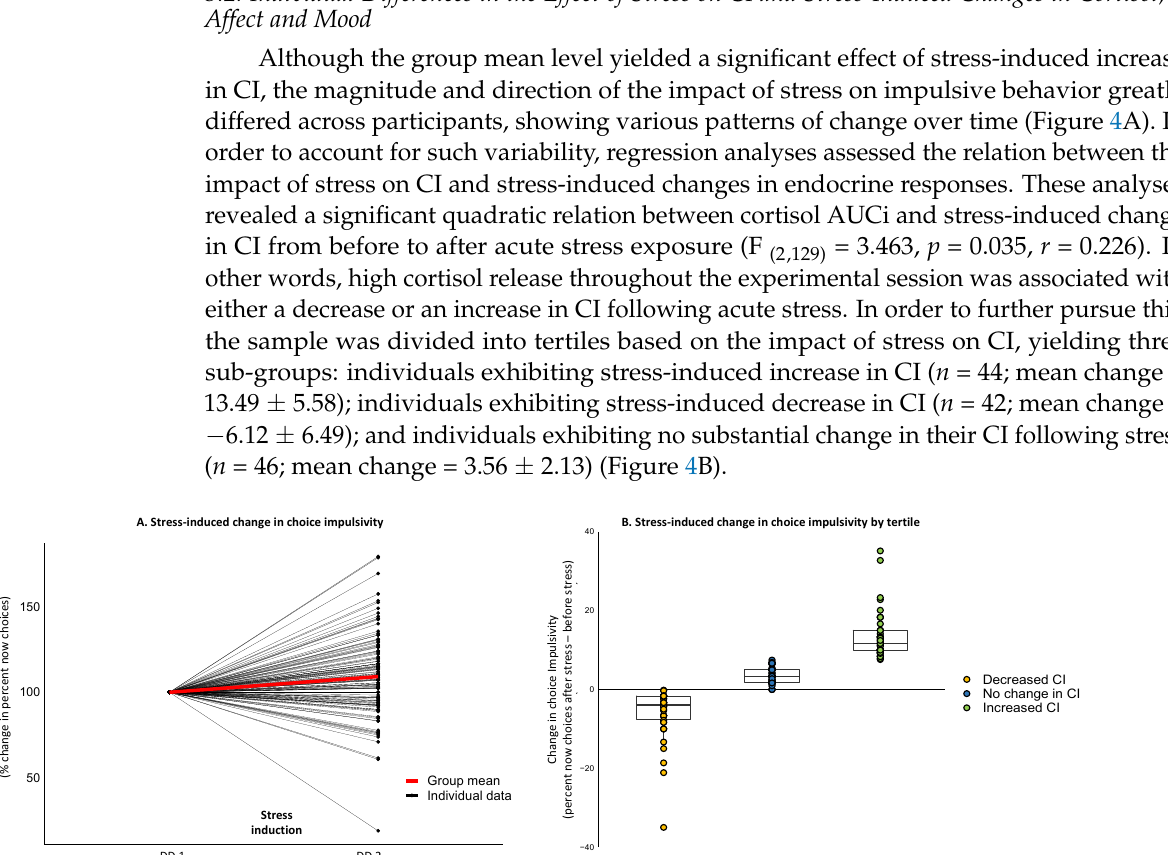
Figure 4. Individual differences in the effect of stress on choice impulsivity. ( A ). Individual patterns of change in choice impulsivity from before to after exposure to acute stress ( n = 132). ( B ). Dividing the sample into tertiles based on the impact of stress on choice impulsivity yielded three sub-groups: individuals exhibiting stress-induced increase in choice impulsivity ( n = 44), individuals exhibiting stress-induced decrease in choice impulsivity ( n = 42), and individuals exhibiting no substantial change in their choice impulsivity following stress ( n =